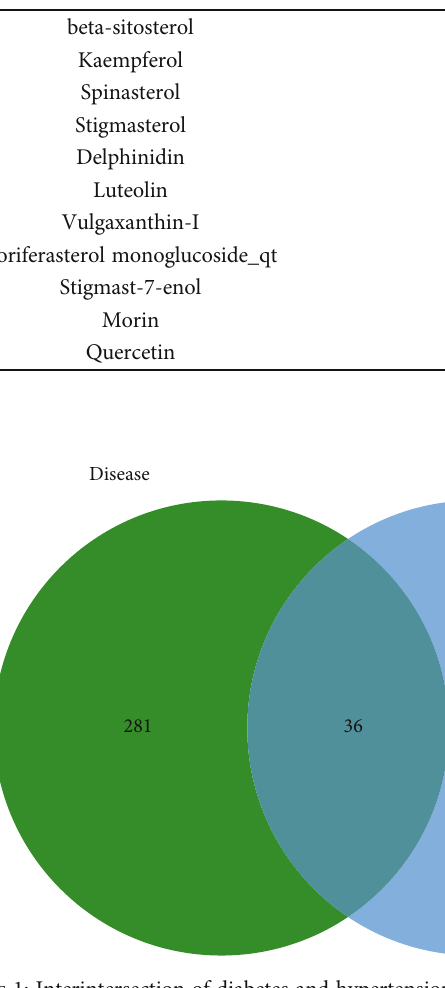
Figure 1: Interintersection of diabetes and hypertension overlap with Prunella vulgaris